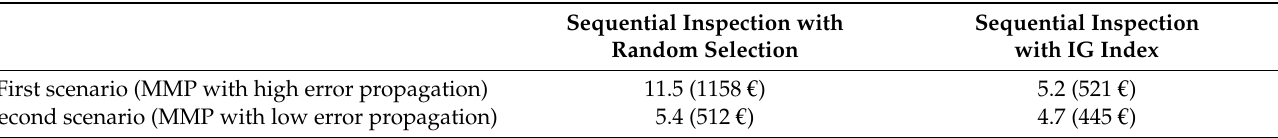
Table 5. Average number of inspections required and cost for two different scenarios applying a sequential inspection based on IG index and random